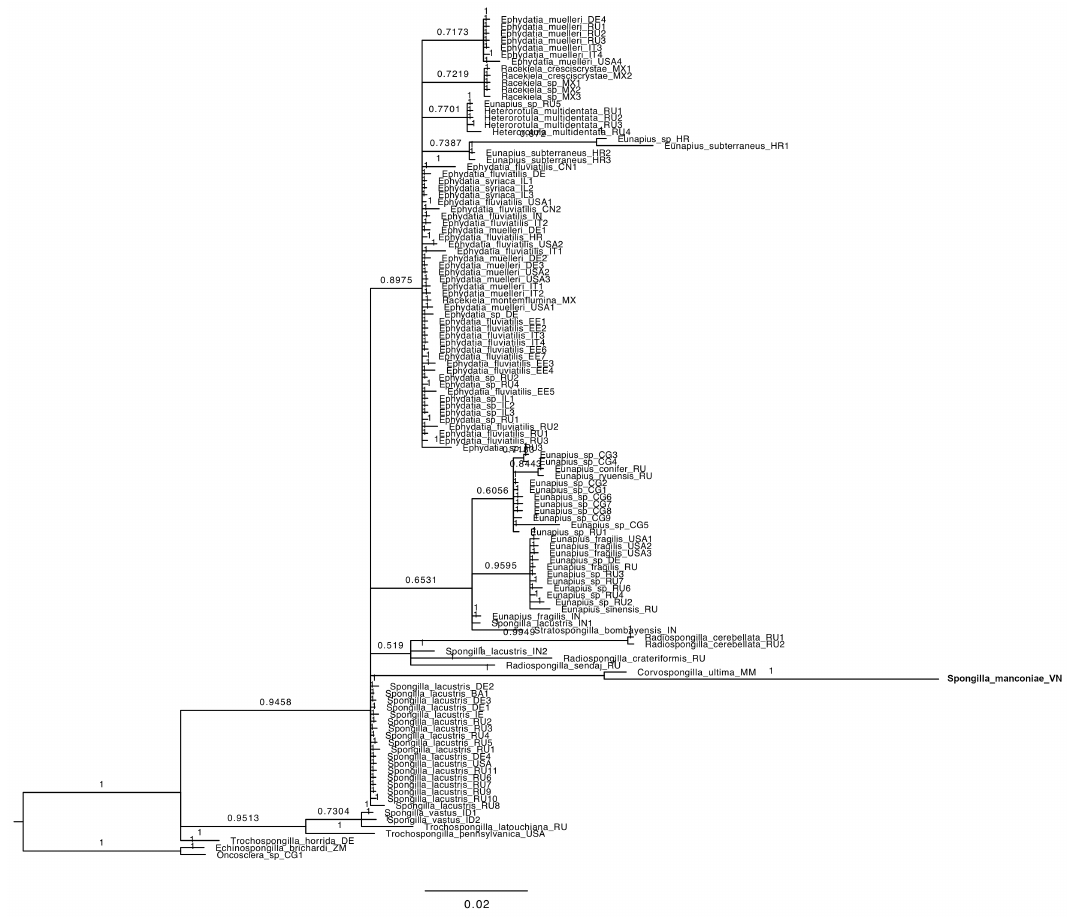
Figure 5. Bayesian inference (BI) phylogenetic tree, applying the concatenated data set of the Cytochrome C Oxidase subunit 1 (COI) and curated ITSs, with the posterior probabilities shown at each node. The analysis was built with the newly described sponge, Spongilla manconiae sp. nov., along with a representative suite of reference sequences in the Spongillidae Family plus two outgroup entries ( Echinospongilla bichardi , and Oncosclera sp.) downloaded from the GenBank database. The country codes and Accession numbers can be found in Supplementary Table 1.